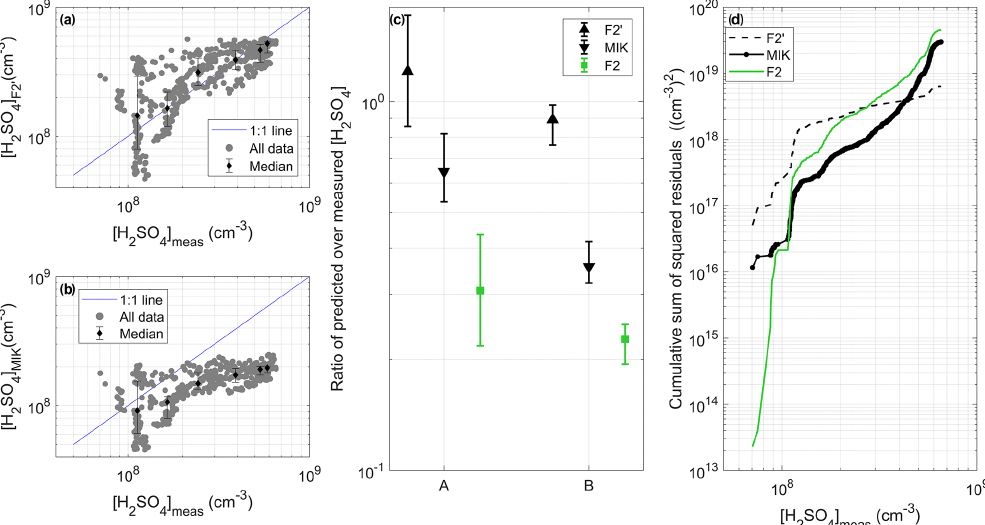
Figure 9. (a) Predictions retrieved by the proxy F2’ as a function of [H 2 SO 4 ] measured during STRAP. Panel (b) is the same as panel (a) but for MIK. In panels (a) and (b) , the data points were also divided into six bins with an equal number of data points based on measured [H 2 SO 4 ]. The medians (markers) and the 25th and 75th percentiles (error bars) of [H 2 SO 4 ] predicted in each bin are also shown. (c) Ratio between predicted and measured [H 2 SO 4 ], separately for the concentrations below (corresponding to A) and above (corresponding to B) 3 × 10 8 cm − 3 . The results obtained with F2 are also reported for direct comparison. For each proxy, the marker represents the median of the ratio, and the lower and upper limits of the error bars indicate the 25th and 75th percentiles respectively. (d) Cumulative sum of squared residuals associated with the different